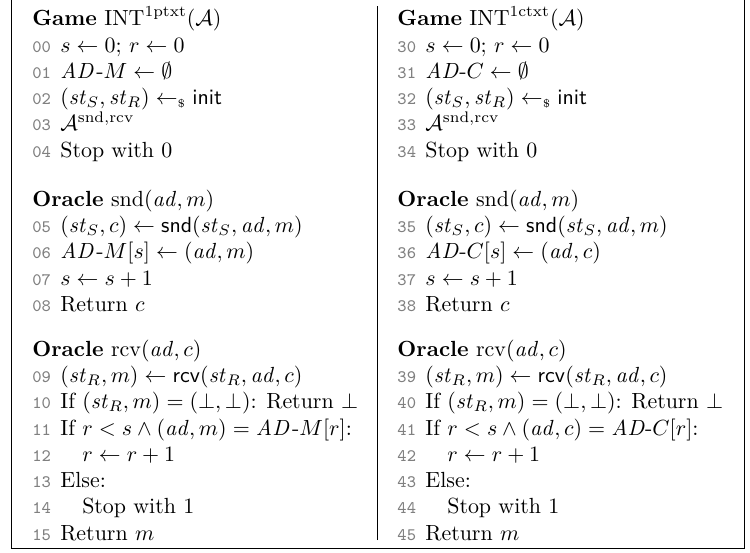
Figure 7: Games for plaintext integrity (left) and ciphertext integrity (right) for unidirec- tional channels. (See also Figure 3 for an explanation of the